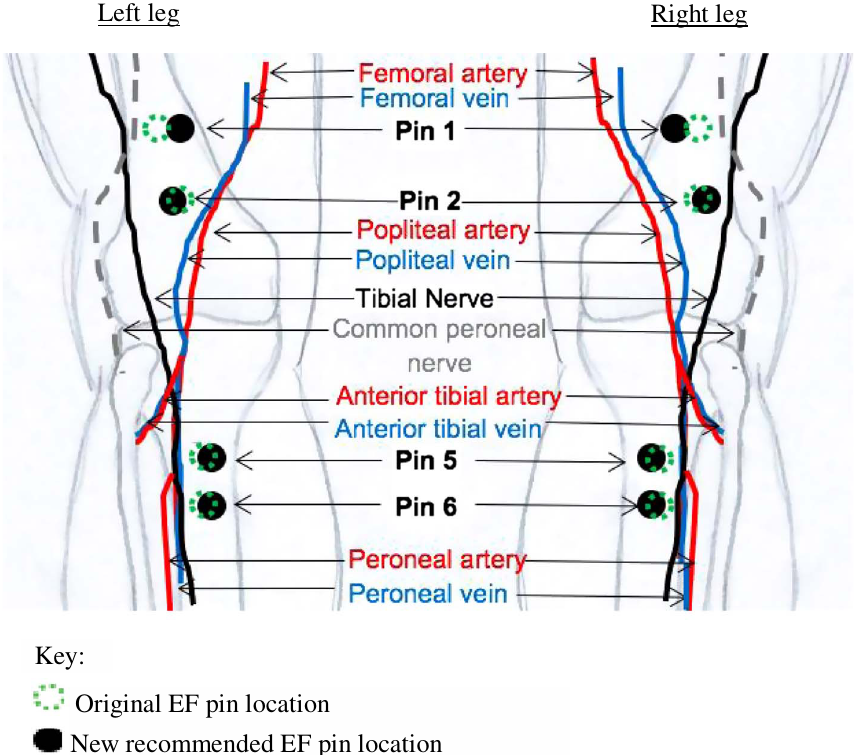
Figure 4. This fi gure represents the original locations of the EF pins 1, 2, 5 and 6 and compares these data against where the pins should be placed, after analysing the